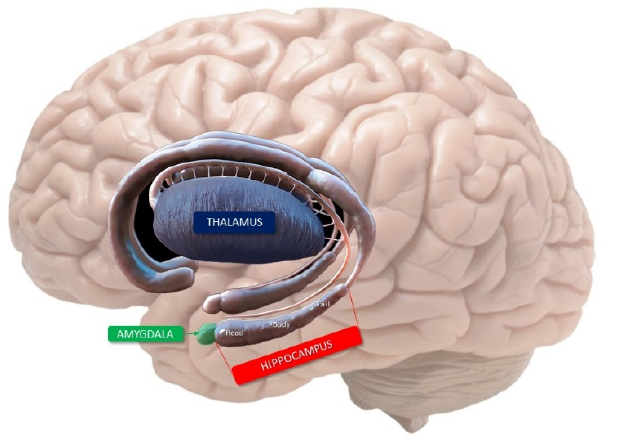
Figure 1. Limbic system of the human brain. The hippocampus with its three segments, the amygdala and the thalamus are evident.